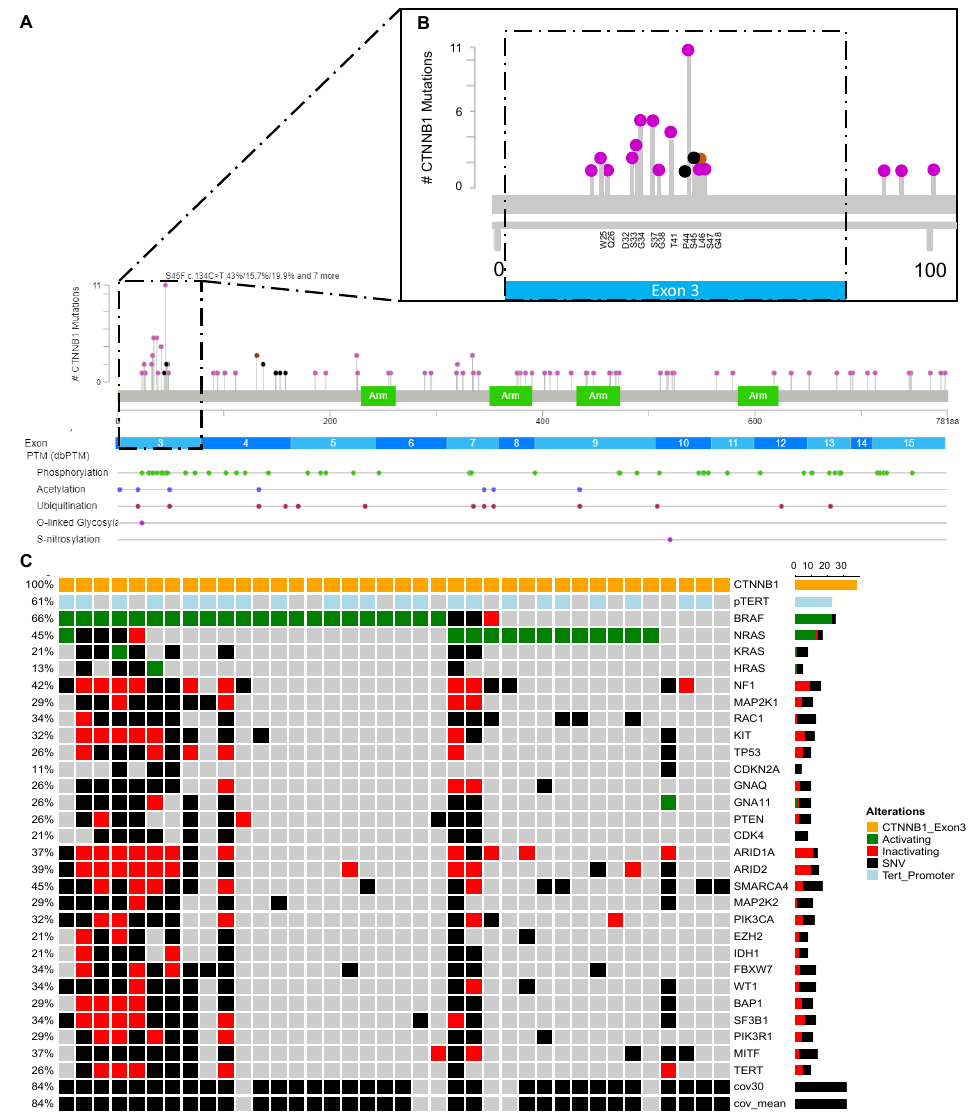
Figure 2. Figure was generated and adapted using the MutationMapper provided by www.sbioportal. org [40,41]. All identified mutations of melanoma harboring a CTNNB1 mutation in the hotspot region in exon 3 of CTNNB1 and additional mutations within these tumors were mapped ( A ). Hotspot region exon 3 is shown in detail in ( B ). Oncoprint of all n = 38 CTNNB1 mutant melanoma samples ( C ).